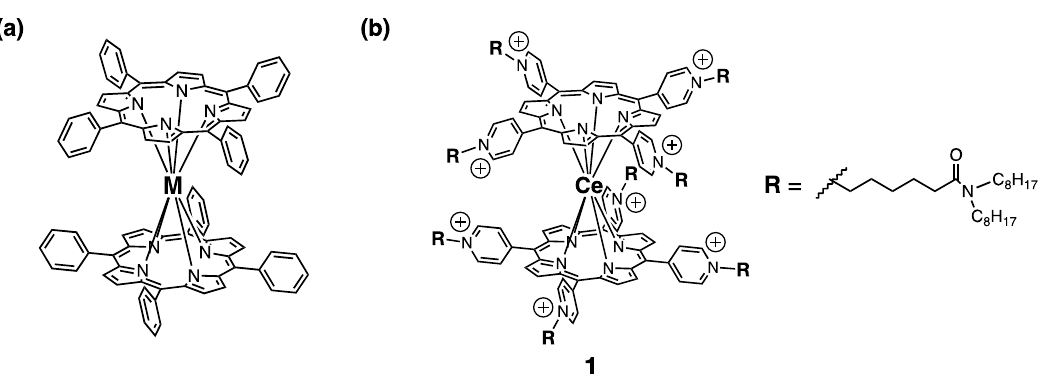
Figure 1. ( a ) Double-decker porphyrin complex and ( b ) Bis{ meso -tetrakis(4- N -alkylpyridiniumyl)porphyrinato}cerium ( 1 ) prepared in this work.